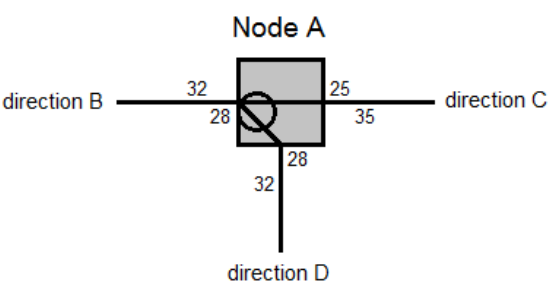
Figure 11. Splitting and joining of trains